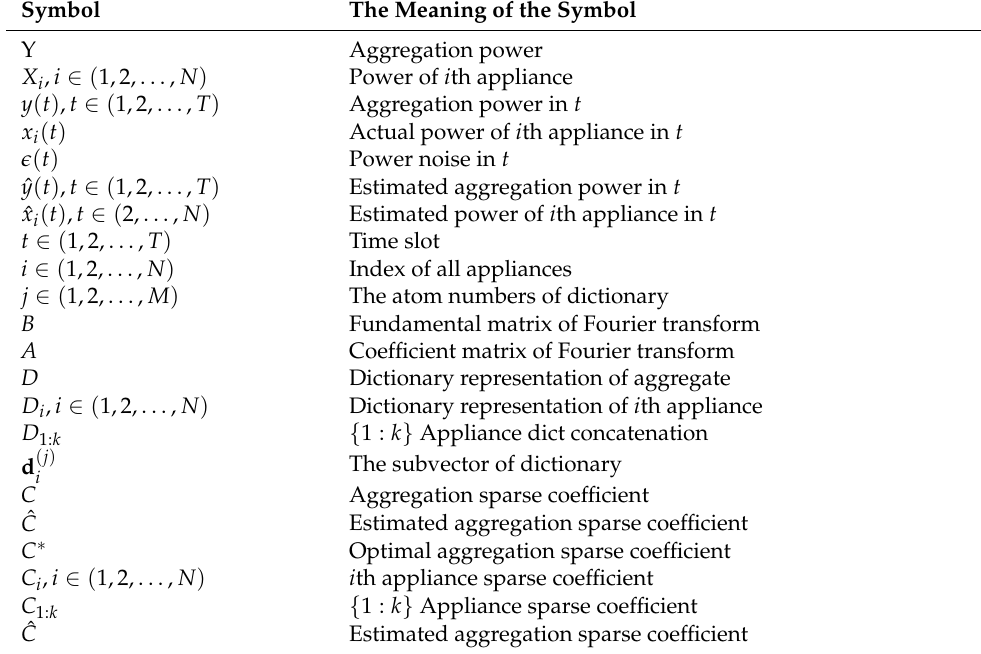
Table 1. Academic terms covered in this